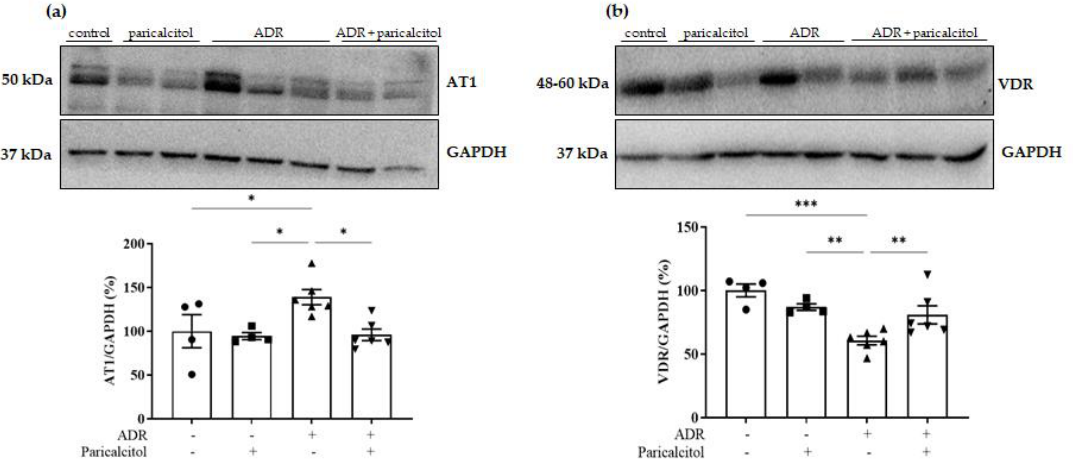
Figure 11. ( a ). Densitometric ratios among AT1. ( b ). Densitometric ratios among VDR. Densitomet- the control group. The control value was designated as 100%. Data are expressed as mean ± SEM. n = 4–6 for each group. Data from the control (dots), paricalcitol (squares), ADR (up triangles), and ADR + paricalcitol (down triangles) groups. * p < 0.05; ** p < 0.01; *** p <